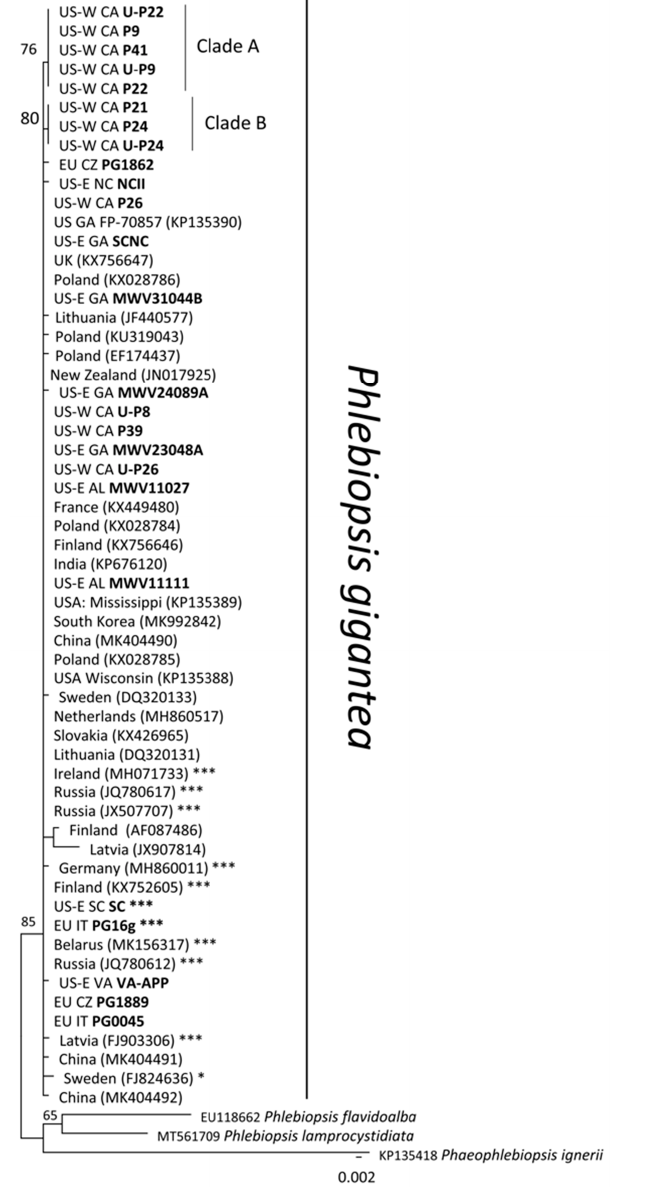
Figure 4. Maximum-likelihood phylogram obtained from the ITS sequence alignment of Phlebiopsis gigantea sequences. Phlebiopsis flavidoalba, Phlebiopsis lamprocystidiata and Phaeophlebiopsis ignerii were used as outgroup taxon. ML bootstrap percentages ≥ 70% are given above clade branches. Labels indicate: geographic area, state, isolate code (in bold for sequences newly generated) and GenBank code brackets for sequences retrieved from NCBI. * insertion of -AA- in ITS1 region. *** : insertion of -ATTTA- in ITS1